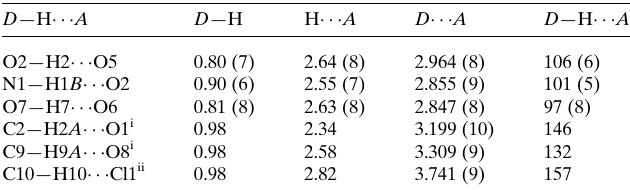
Table 2 Hydrogen-bond geometry (A˚ , (cid:5) ).